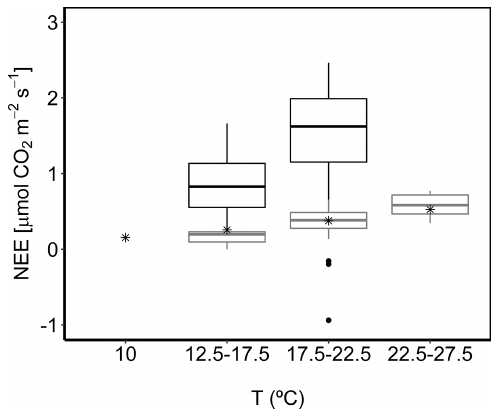
Figure 7. Box plots of the nighttime NEE fluxes for 5K temperature classes under soil moisture conditions that ranged from very dry to dry (VWC classes 1 and 2: grey boxes) and from intermediate to wet (VWC classes 3 and 4: black boxes). The asterisks indicate the respiration fluxes calculated following the parameterization of the Lloyd–Taylor function. Table 2. Values of the two constants of the Michaelis–Menten as- similation function obtained for the separate 5K